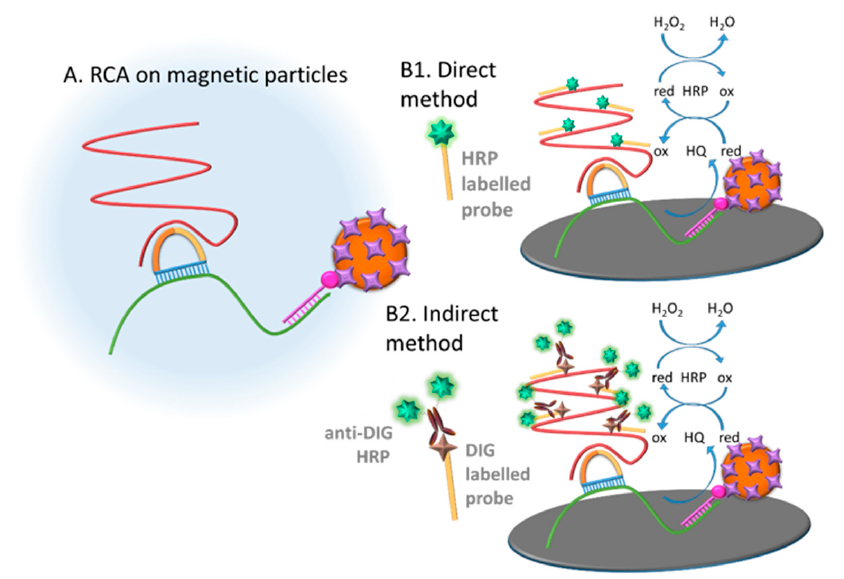
Figure 5. Schematic representation of the electrochemical genosensing of E. coli by rolling circle amplification. ( A ) RCA on the streptavidin-MPs; ( B1 ) Direct labelling. Hybridization with the readout probe 1 (HRP labelled) acting as electrochemical reporter. ( B2 ) Indirect labelling. Hybridization with the readout probe 2 (digoxigenin modified) and incubation with the electrochemical reporter antiDIG-HRP. In both cases, the electrochemical determination is performed by square wave voltammetry upon addition of the mediator HQ and the substrate H 2 O 2 for the HRP.